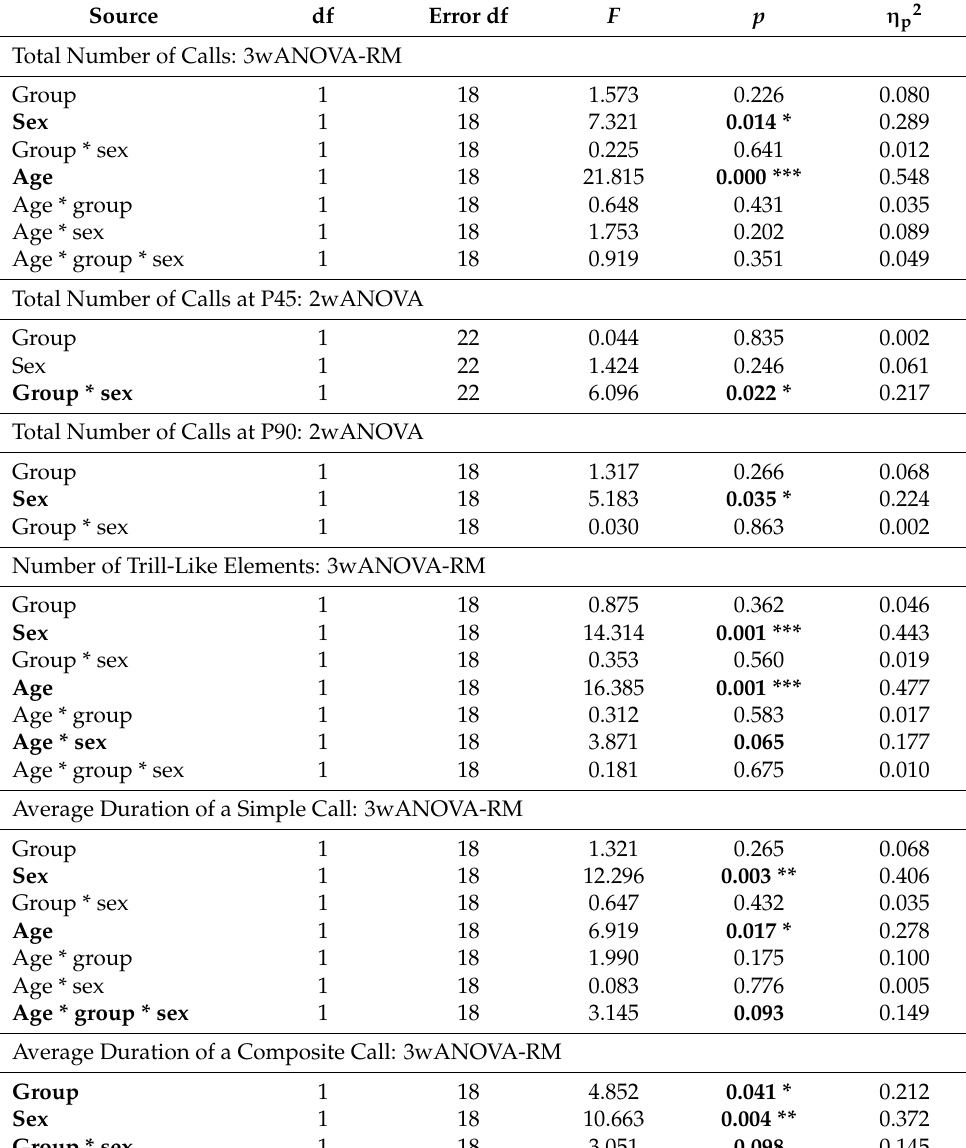
Table A5. Three-way ANOVA-RM and two-way ANOVA table for ultrasonic vocalization